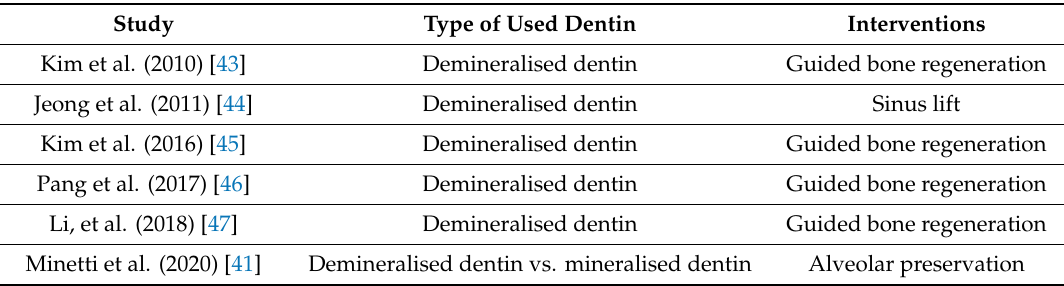
Table 2. Table resuming the clinical trials available in the literature on the use of dentine derivates. Study Type of Used Dentin Interventions Kim et al. (2010) [43] Demineralised dentin Guided bone regeneration Jeong et al. (2011)